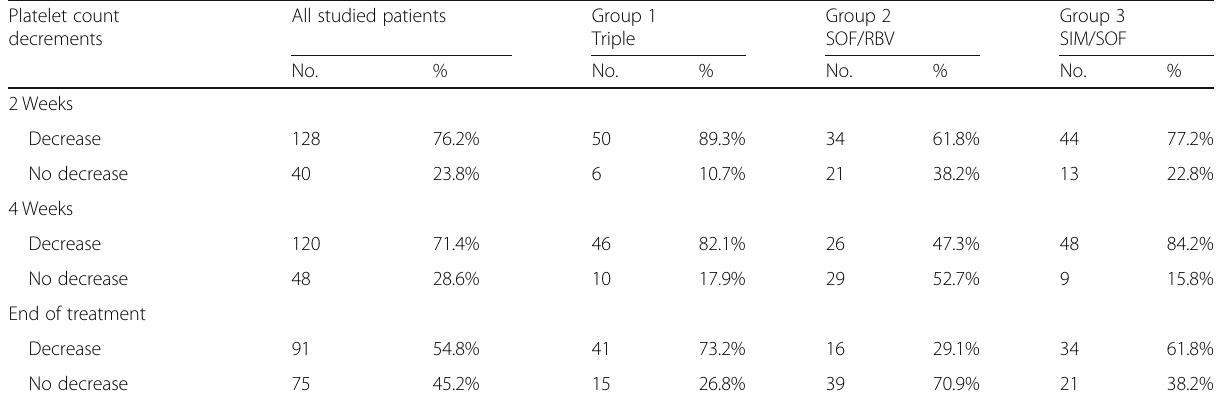
Table 3 Platelet decrement during treatment Platelet count decrements